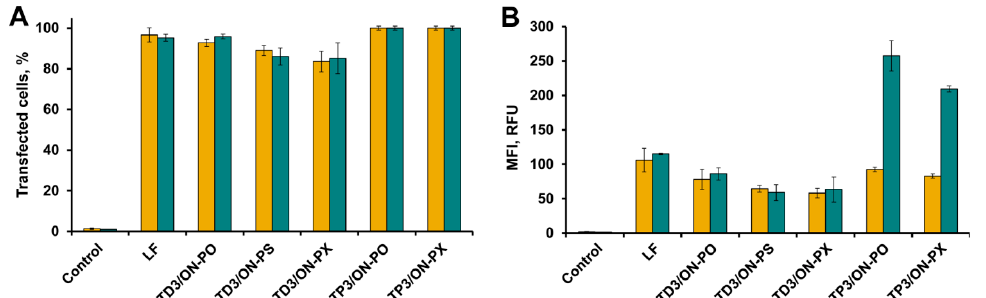
Figure 5. Transport oligonucleotide mediated accumulation of FAM-dONs bearing different sugar phosphate backbone modifications in A549 (yellow bars) and HEK293 (green bars) cells. The percentage of fluorescent cells ( A ) and mean fluorescence intensity ( B ) were measured using flow cytometry 4 h post transfection. LF = transfection of FAM-ON-PO mediated by Lipofectamine 2000. Data presented as the mean ±